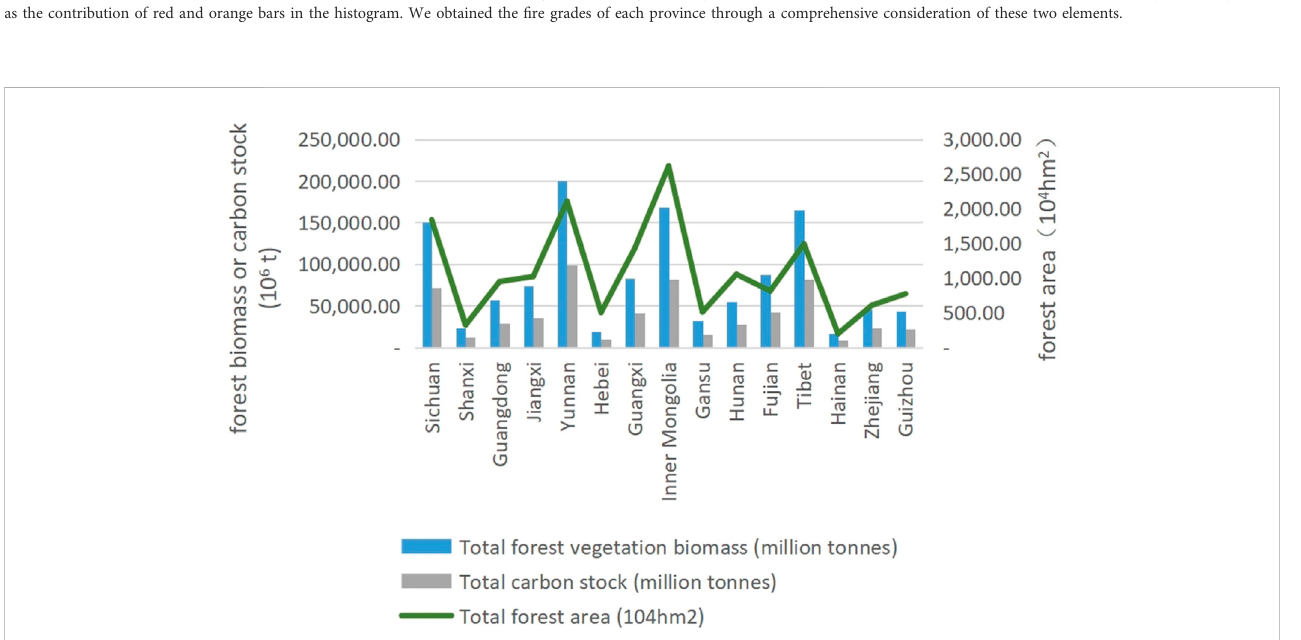
TABLE 1 Fire risk grades of sample provinces. The grades of provinces in forest fi re risk (the grade of provinces is a comprehensive consideration of the two elements, that is, risk frequency and risk intensity, in column 2 and column 3 respectively)